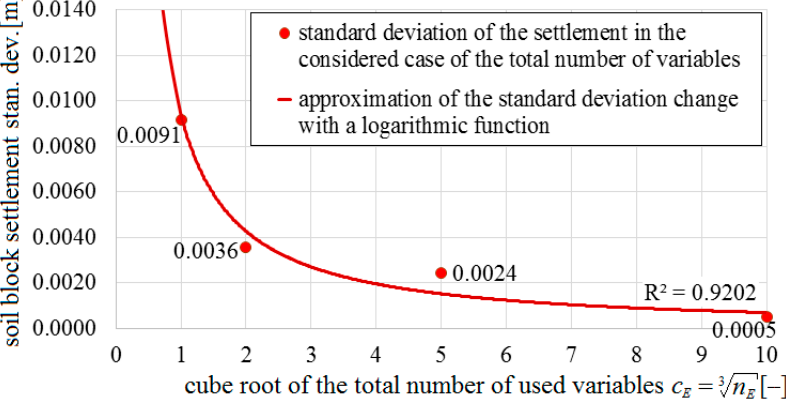
Figure 13. Soil block settlement dispersion versus the cubic root of the number of random variables √ = 3 c n . c = 3 n E E E E